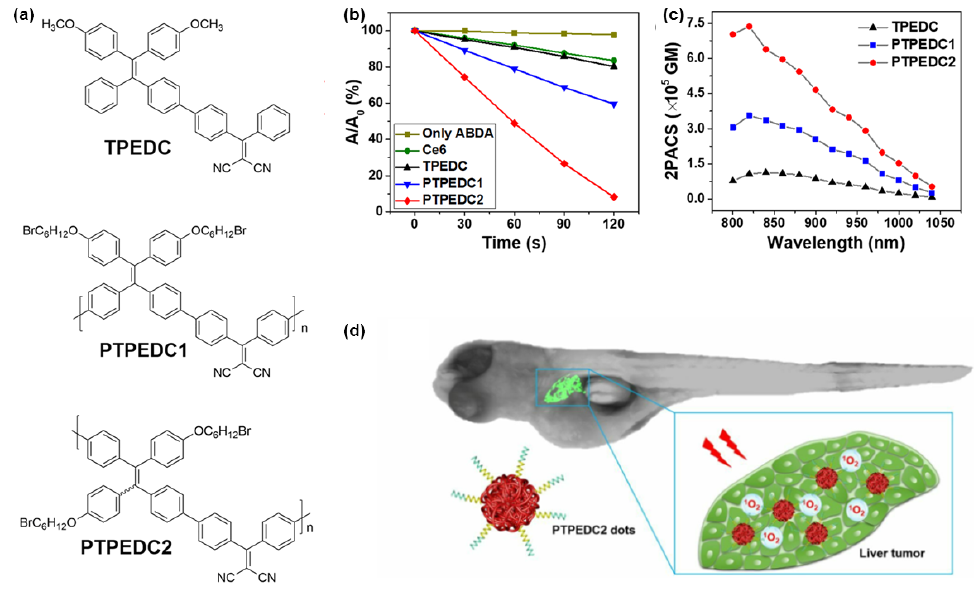
Figure 10. ( a ) The chemical structures of TPEDC, PTPEDC1, and PTPEDC2. ( b ) The 1 O 2 generation ability of TPEDC, PTPEDC1, PTPEDC2, and Ce6 upon exposure to white light for different irradiation times. ( c ) Two-photon absorption cross section (2PACS) spectra of the three materials in aqueous solution. ( d ) 2PE-PDT performance for in vivo zebrafish liver tumor treatment. Reprinted with the permission from Ref. [29]. 2019, American Chemical Society.